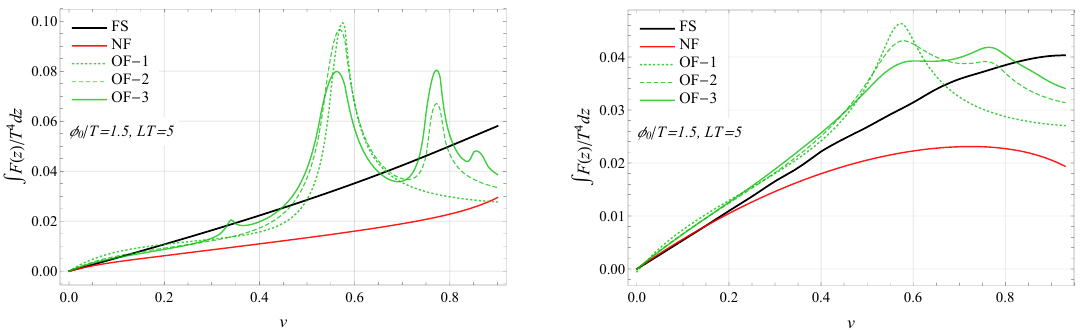
Figure 2 . Friction acting on the bubble wall as a function of the velocity. In the left plot only the top annihilation channel has been taken into account, while in the right one both annihilation and scattering are considered. The black solid line corresponds to the solution of the full Boltz- mann equation (FS, our result), the dotted, dashed and solid green lines are obtained with the old formalism (OF) at order 1 , 2 and 3 respectively [9, 30], while the red line corresponds to the new formalism (NF)